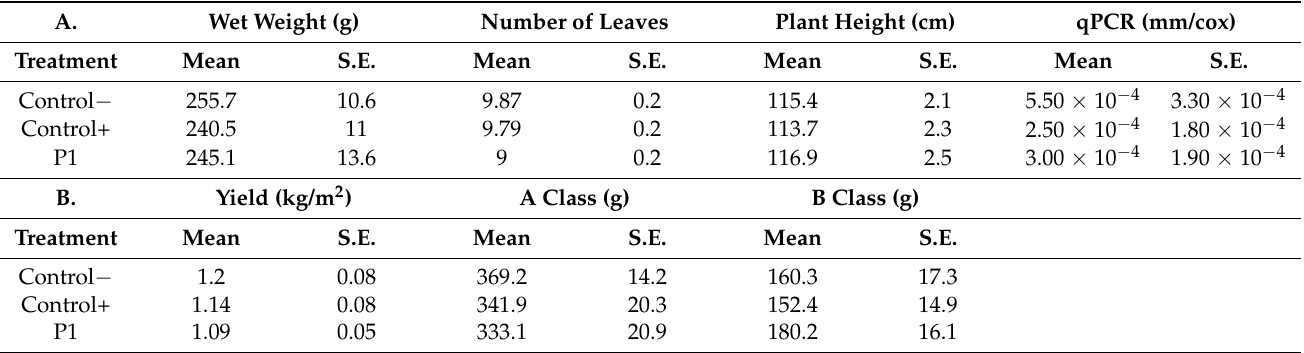
Table 5. Trichoderma asperellum late wilt control in the field at 41 (A) and 82 (B) DAS 1 .